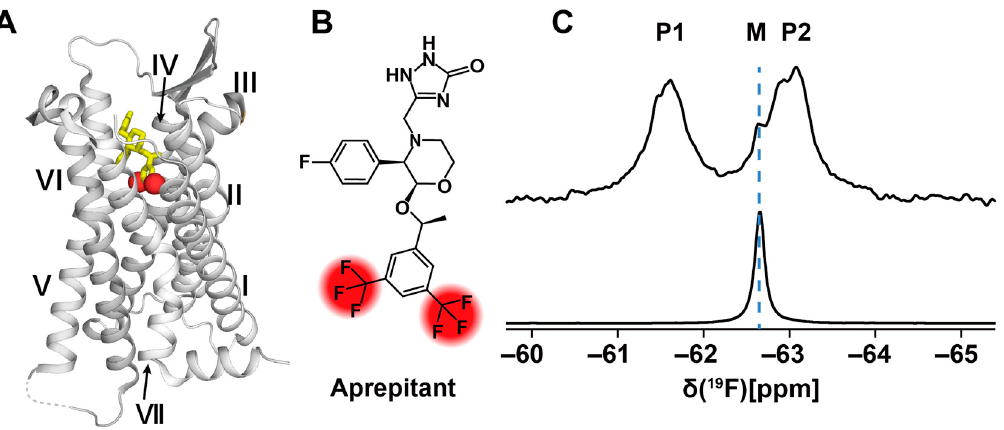
Figure 6. 19 F-NMR observation of the ligand aprepitant bound to NK1R. ( A ) Crystal structure of the NK1R complex with aprepitant (PDB: 6J20). NK1R is shown in ribbon presentation with grey color. Aprepitant is shown in yellow stick presentation, with red spheres representing the trifluoromethyl groups. The transmembrane helices are identified with roman numerals. ( B ) Chemical structure of the drug aprepitant. The two –CF 3 groups are highlighted in red. ( C ) 1D 19 F-NMR spectra of aprepitant in complex with NK1R (upper trace) and “free” in DDM/CHS micelles (lower trace). M is the 19 F-NMR signal of micelle-associated “free” aprepitant; P1 and P2 are the two –CF 3 signals of NK1R-bound aprepitant. (Adapted from Figure 4, A and E, in reference [99] ).